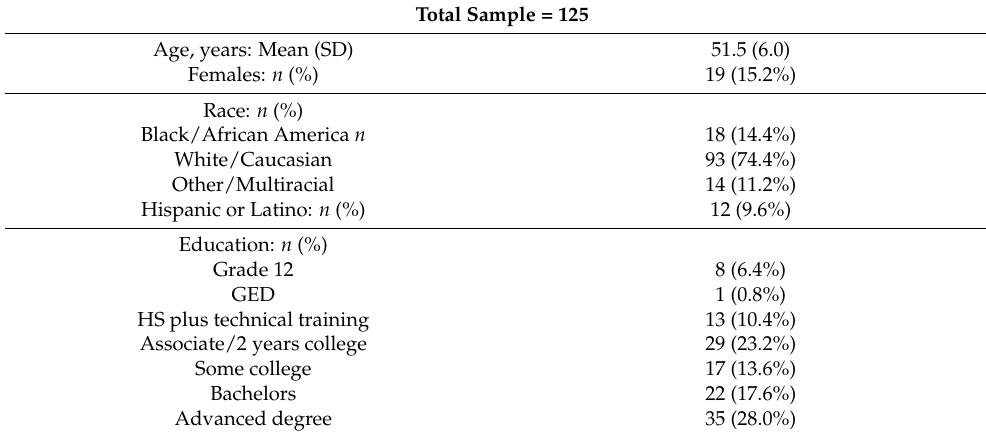
Table 1. Population